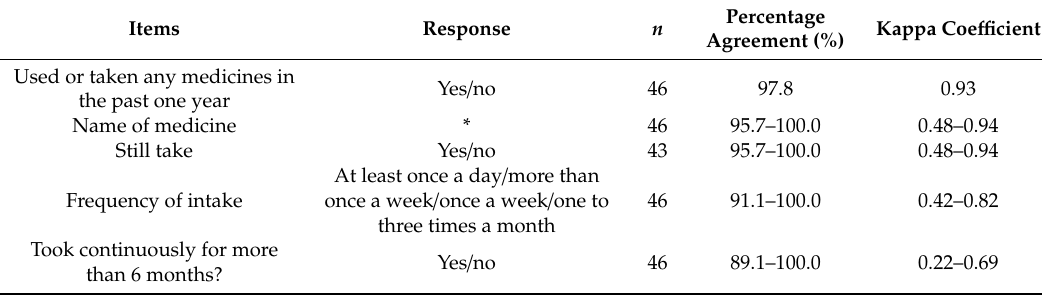
Table 5. Cohen’s kappa ( k ) coe ffi cient for medicine